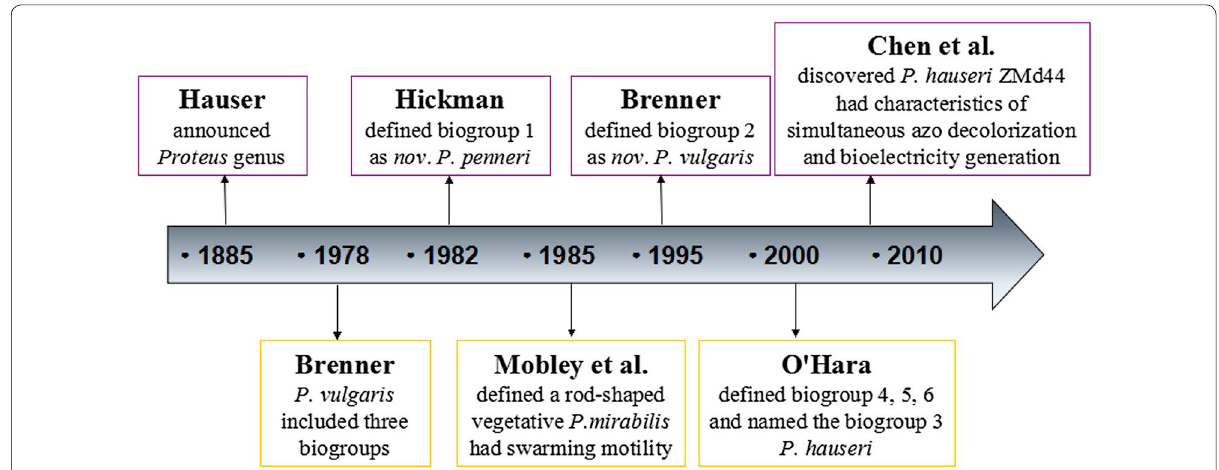
Fig. 1 History of Proteus genus‑associated with findings of milestone